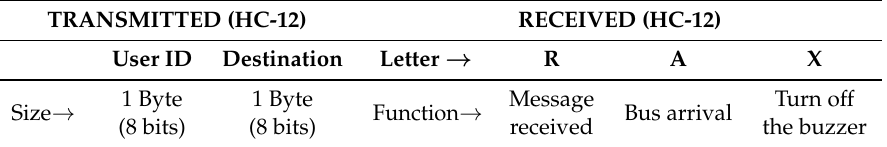
Table 1. Information transmitted/received by the MOVI-ETA